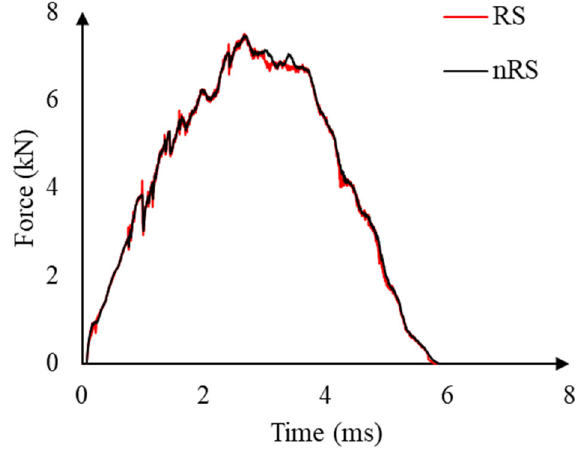
Figure 3. Comparison of force–time curves for the panel subjected to multiple impacts from simula- tions with the rest step (RS) and without the rest step (nRS).